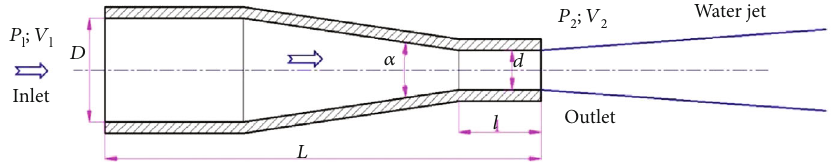
Figure 7: Nozzle structure and jet fl ow characteristics.